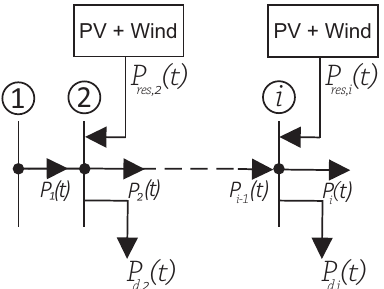
Figure 1. Simplified MG Model under balanced